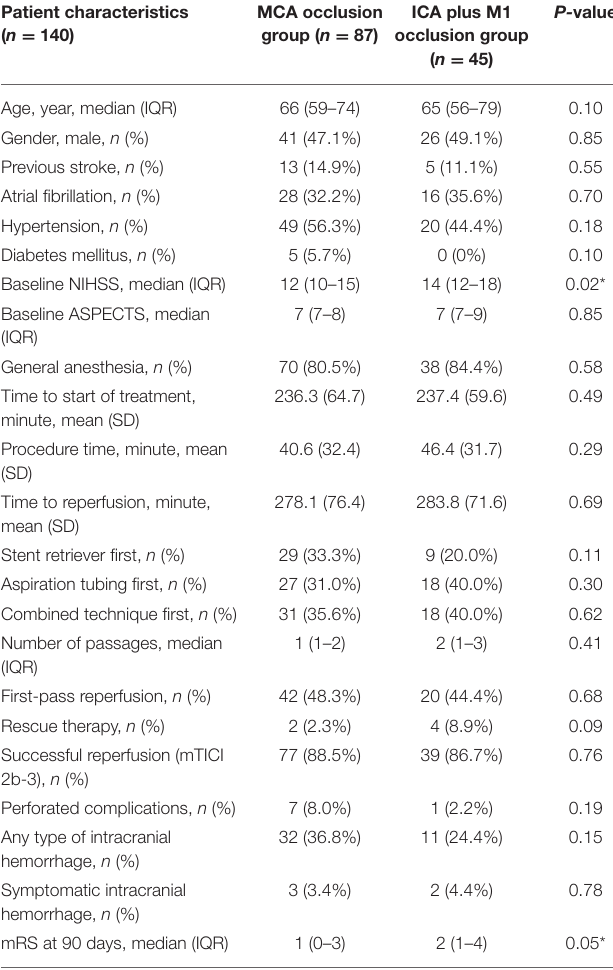
TABLE 6 | Subgroup analysis based on occlusion